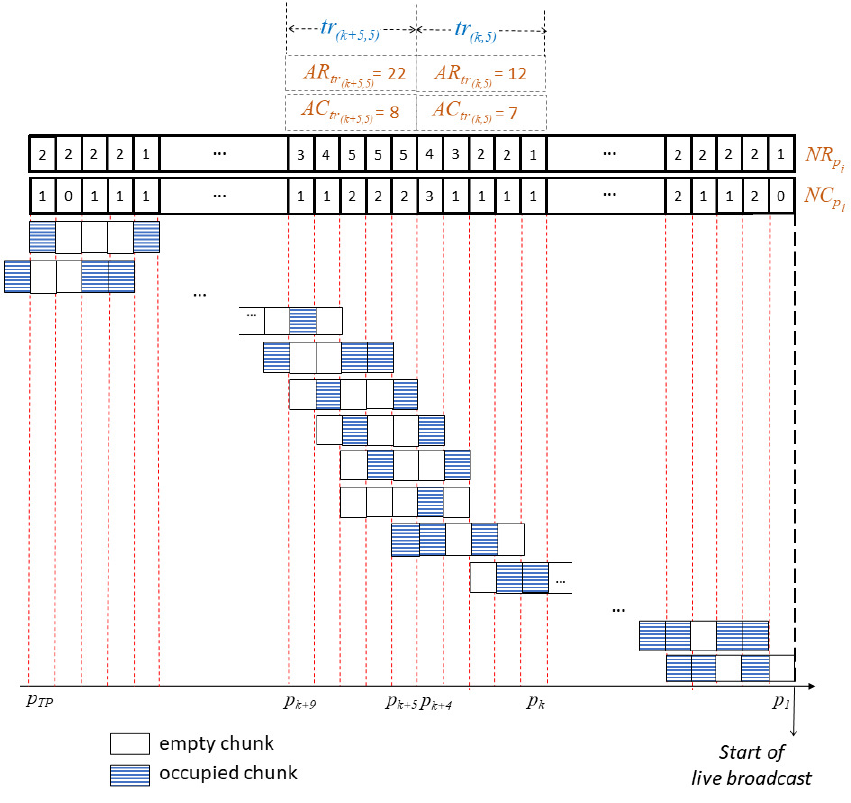
Figure 4. A buffering scheme based on the R atio of Playback R equests to Chunk C opies. In our time-shifted live streaming system based on P2P networks, PVRs